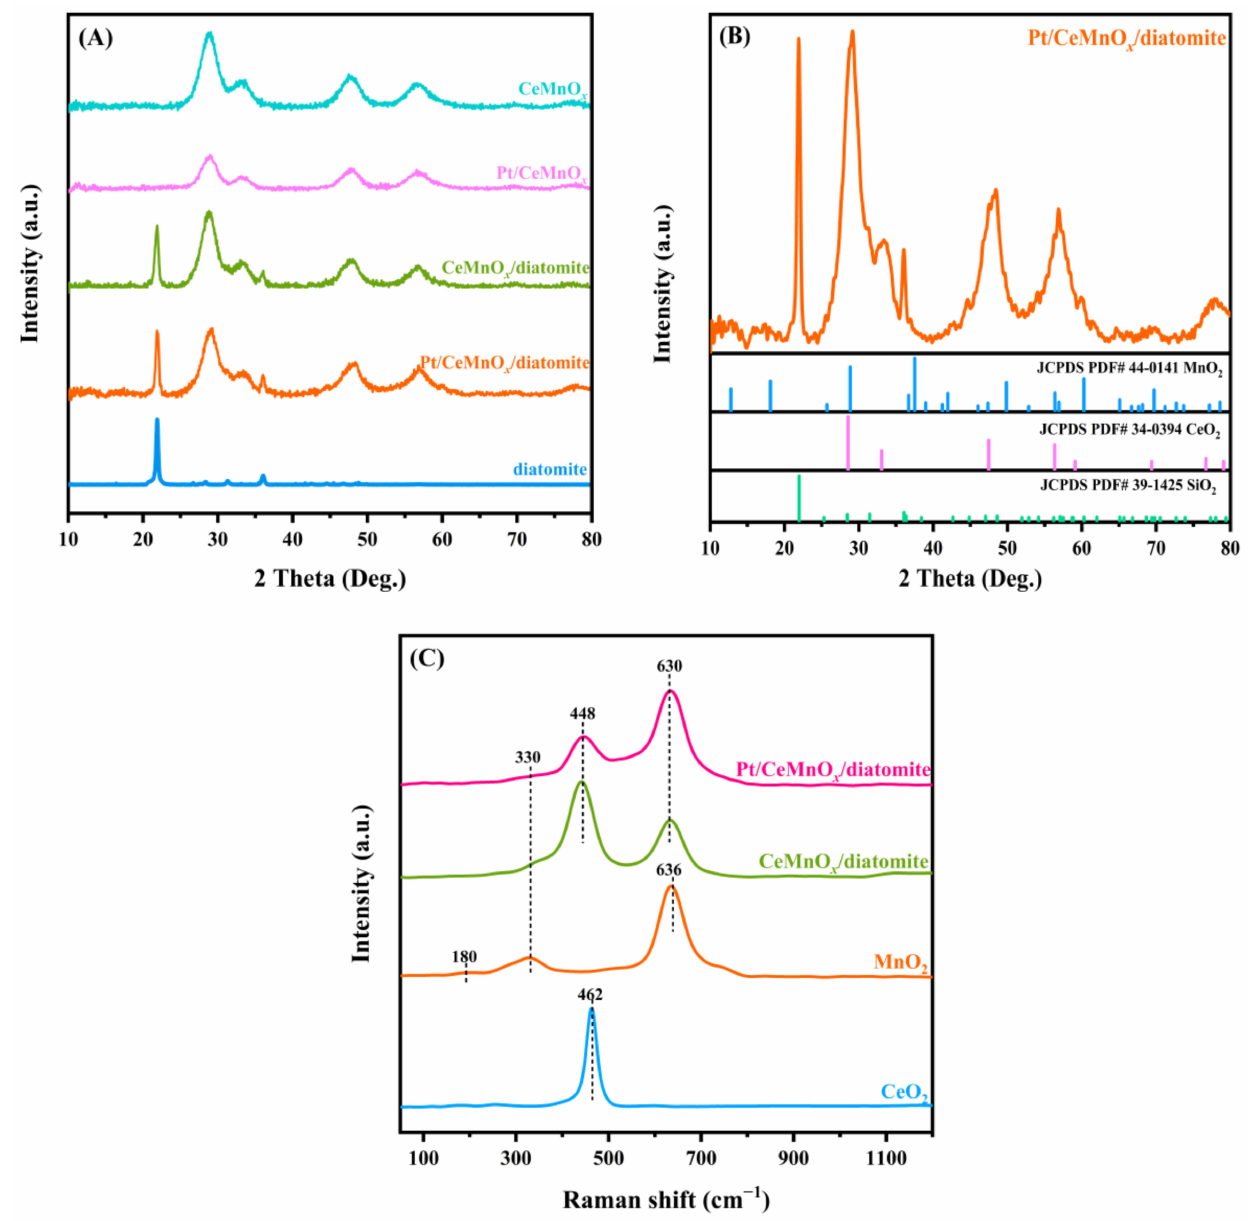
Figure 1. ( A , B ) XRD patterns and ( C ) Raman spectra of the